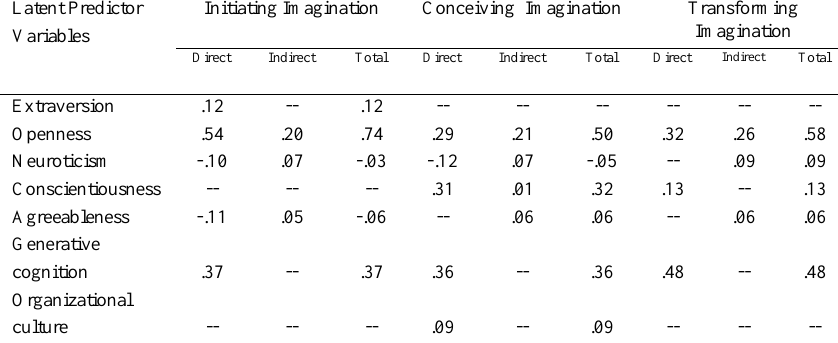
The direct and indirect effects of the mediation model (n =